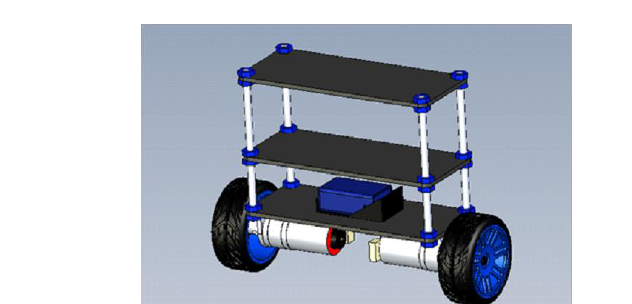
Figure 6. Electrical design